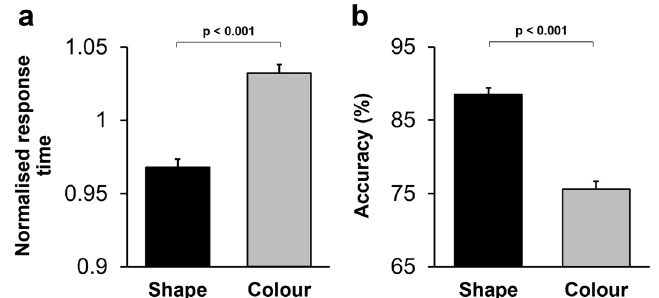
Figure 2. Dimensional bias influenced monkeys’ performance in the delayed matching to sample task. ( a ) Mean normalised response time is shown for colour- and shape-DMS trials. Normalised response time was significantly shorter in trials where shape-matching was required than in trials where colour-matching was required. ( b ) The mean percentage of correct responses (accuracy) is shown for colour- and shape-DMS trials. Accuracy was significantly higher in shape-DMS trials compared to colour-DMS trials. In all Figures, error bars show the standard error, and p values indicate the significance level of the pairwise comparisons (with Bonferonni correction for multiple